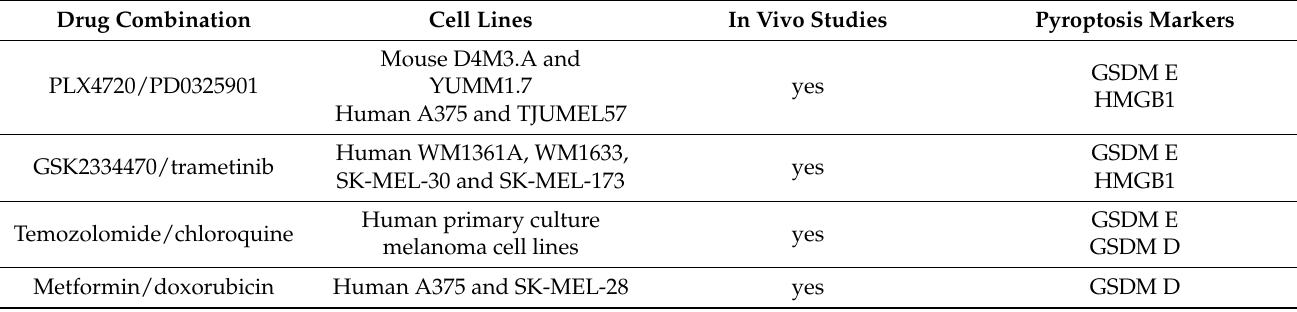
Figure 3. Molecules that induce pyroptosis in melanoma. The chemical structures of BRAF inhibitor, vemurafenib (PLX4720); MEK inhibitors, PD0325901 and trametinib; PDK1 Inhibitor, GSK2334470; DNA alkylating agent, temozolomide; autophagy inhibitor, chloroquine; antihyperglycemic agent, metformin; and toposiomerase II poison, doxorubicin, are reported. Table 1. Drug combinations that induce pyroptosis in posed by Cai et al. [26]. An increased sensitivity to the MEKi trametinib was reported in